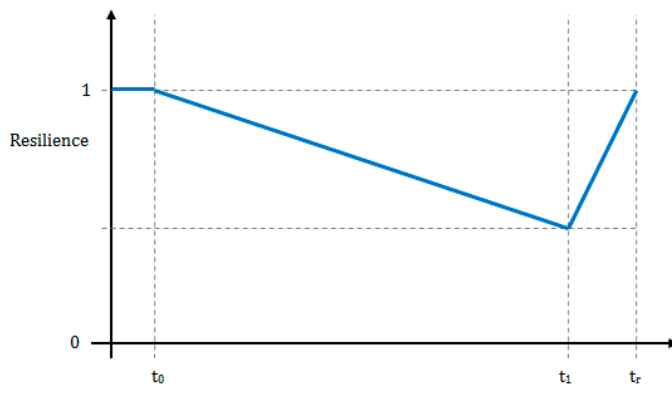
Figure 7. Resilience curve corresponding to a static system performance measure—Option 1.